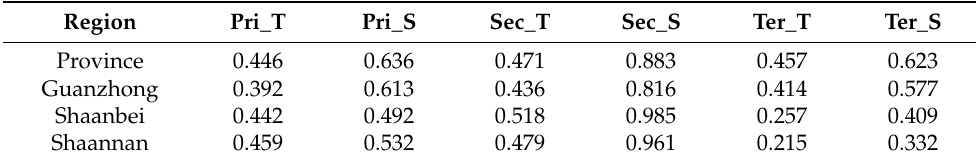
Table 2. Gini coefficient of medical accessibility in different regions. Region Pri_T Pri_S